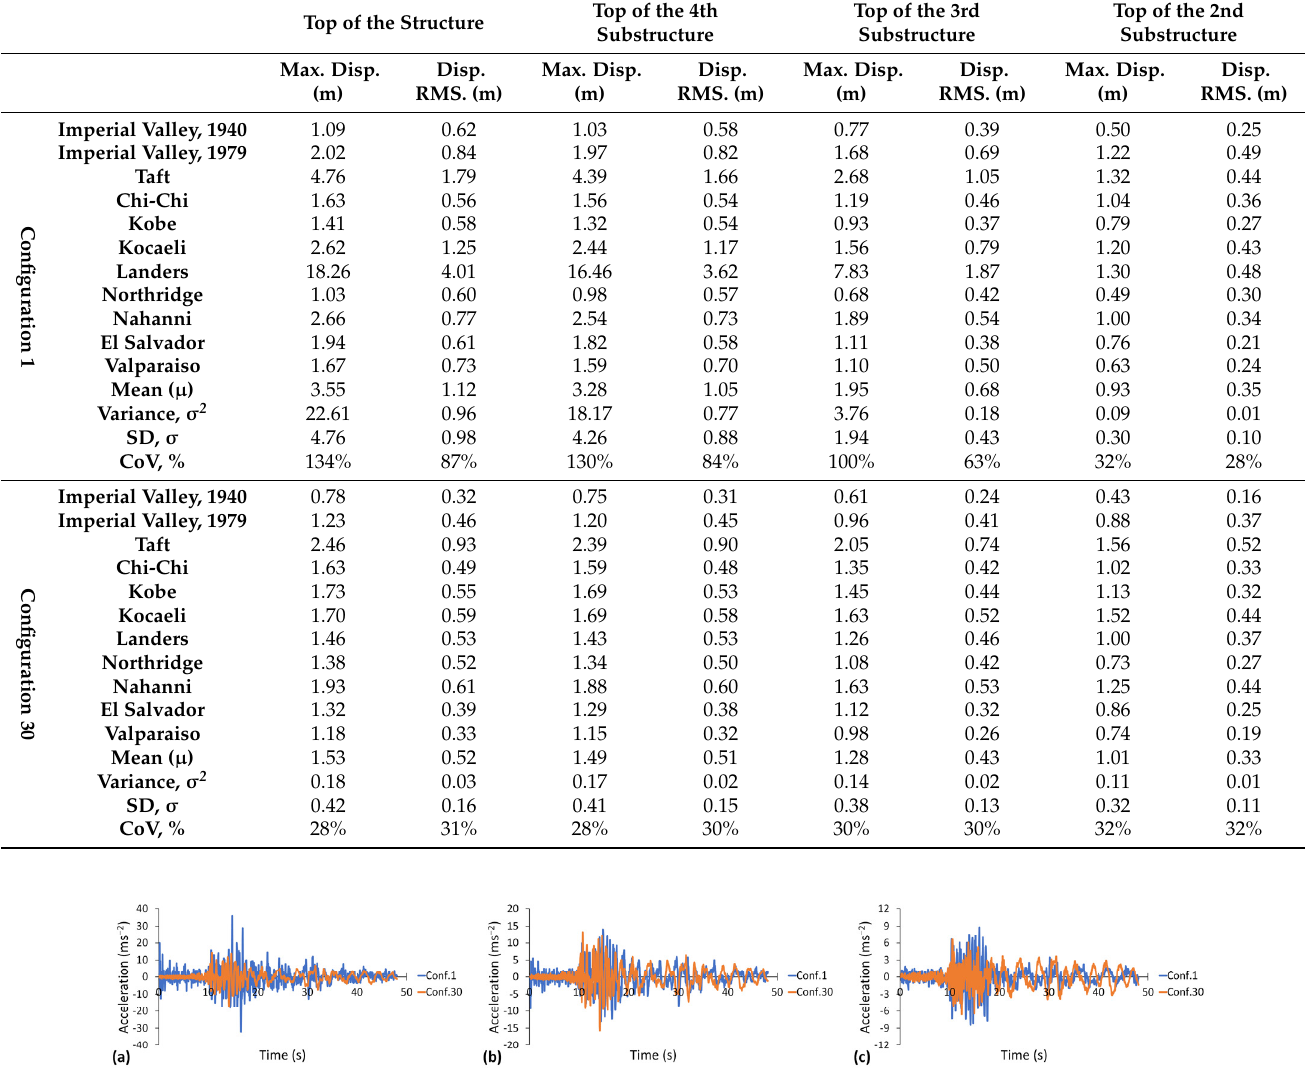
Table 6. Max. Floor Displacement at the Main Points of Structure.